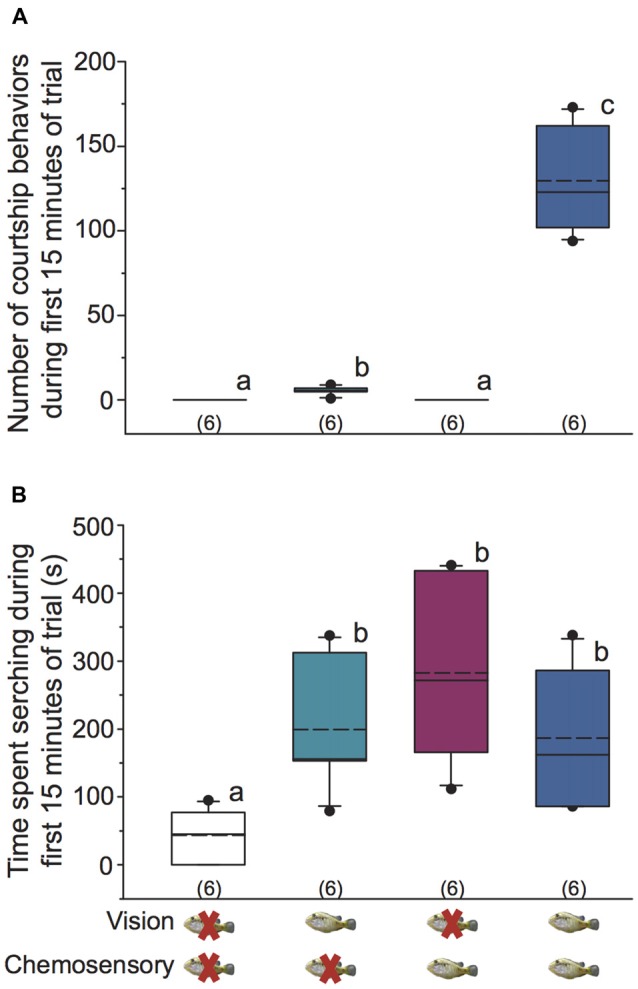
Visual and chemosensory signals from gravid females induce distinct behaviors in dominant A. burtoni males. (A) Focal males require a visual signal from females to engage in courtship behaviors, but visual signals alone are sufficient to induce some courtship. Male courtship behaviors are dramatically increased when both visual and chemosensory signals from females are present. (B) Focal males spend more time searching when a visual, chemosensory, or paired visual-chemosensory signal from females is present compared to control conditions. Different letters indicate statistical differences at P < 0.05 (Kruskal-Wallis (KW) one-way ANOVA on Ranks, SNK post hoc). Box plots were used to represent data: solid line indicates the median and dashed line indicates the mean. The box extends to the furthest data points within the 25th and 75th percentile, and whiskers extend to the 10th and 90th percentile. Closed circles indicate data points outside the 5th and 95th percentile. Sample sizes are shown in parentheses.